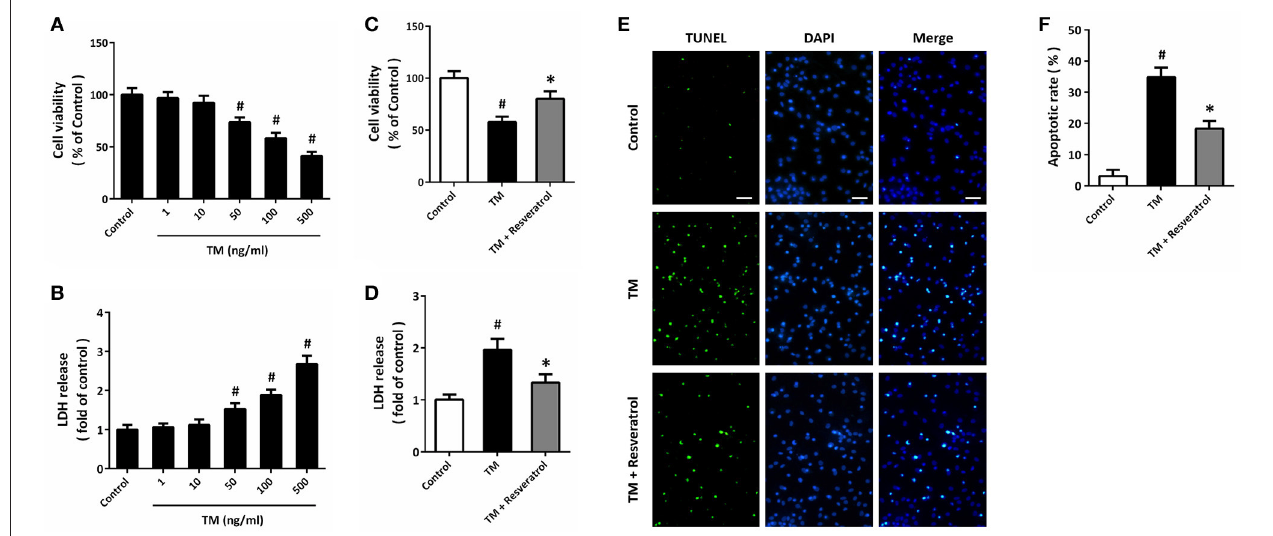
FIGURE 1 | Resveratrol protects against TM-induced toxicity in HT22 cells. HT22 cells were treated with TM at different concentrations for 24h. Cell viability was measured by MTT assay (A) , and cytotoxicity was determined by LDH assay (B) . HT22 cells were treated with 100ng/ml TM with or without 50 µ M resveratrol for 24h, and cell viability (C) and LDH release (D) were measured. TUNEL staining was performed to detect apoptosis, and the nuclei were stained by DAPI (E) . The apoptotic rate was assayed (F) . Data are shown as mean ± SEM. # p < 0.05 vs. Control. * p < 0.05 vs. TM. Scale bar = 50 µ m.